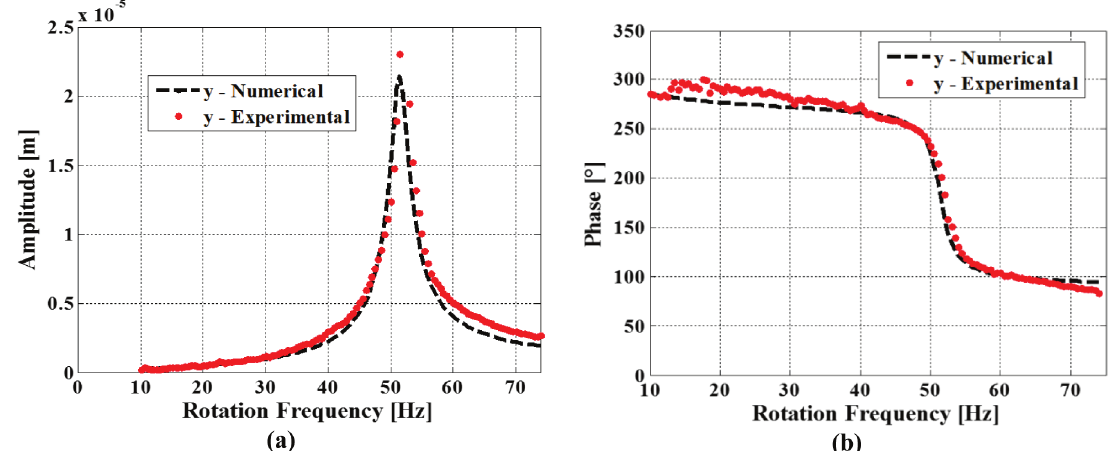
Figure 11 - Unbalanced frequency responses at Bearing 2, horizontal direction: (a) amplitude and (b) phase.